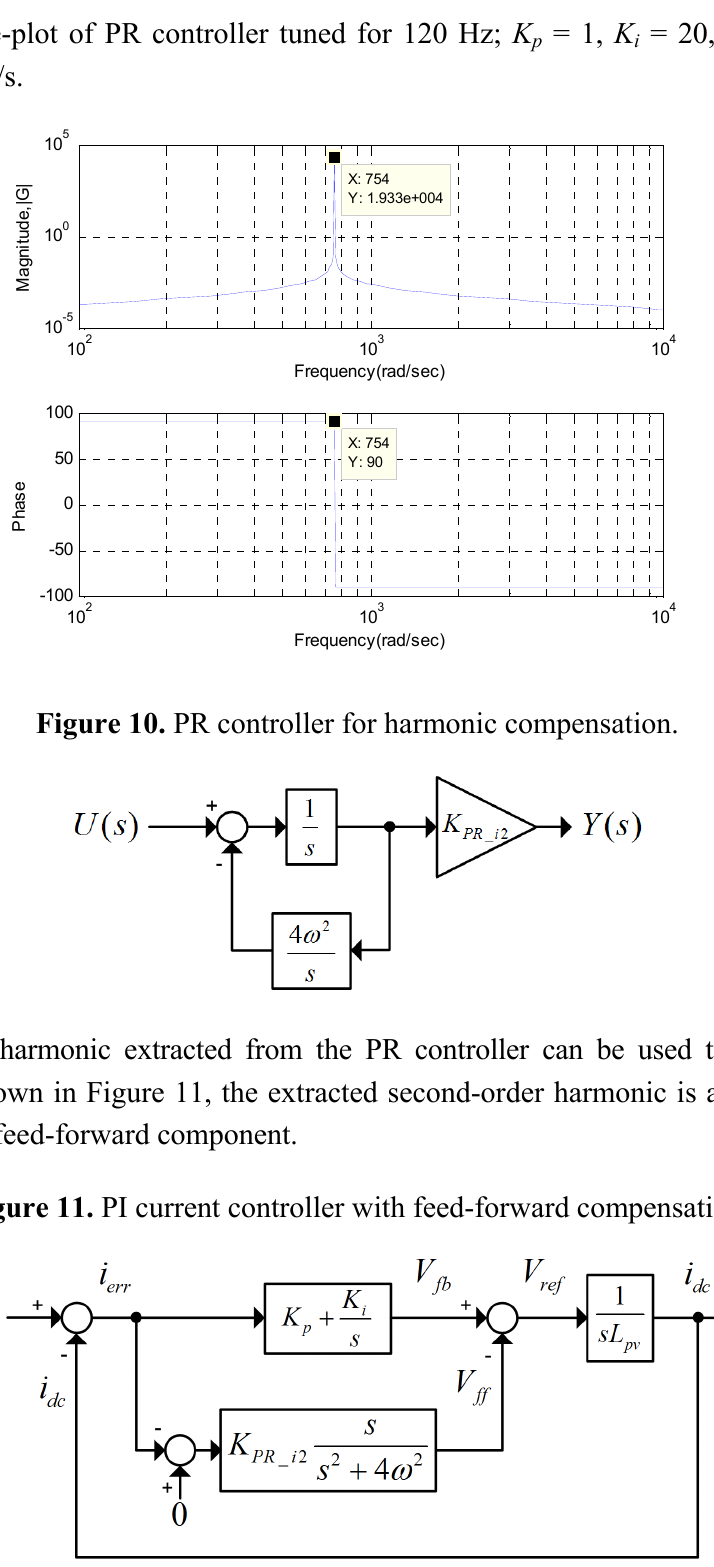
= 1, K = 20, ω = 754 rad/s, p i